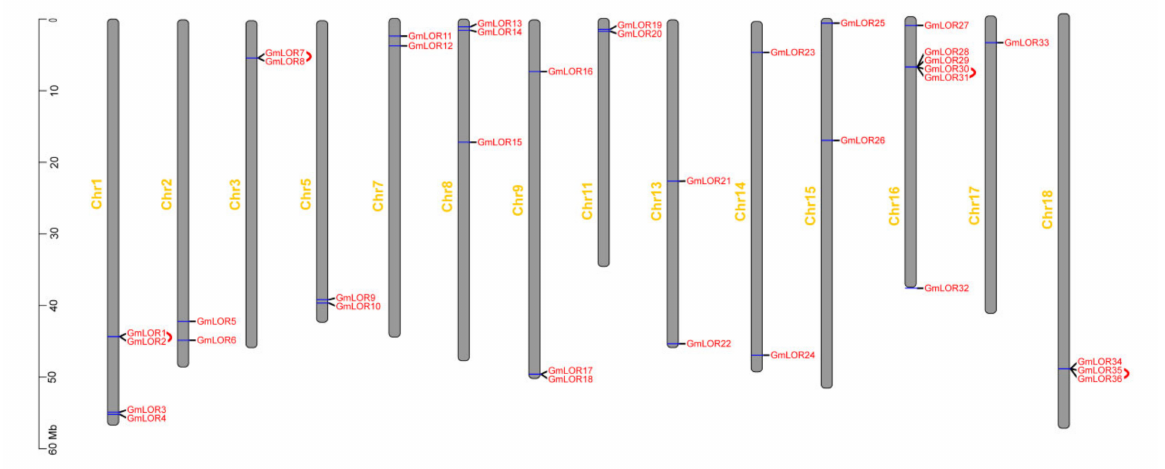
Figure 3. Chromosomal distribution and tandem duplications of GmLORs. The 36 GmLORs were mapped onto soybean chromosomes based on their physical positions. Four tandemly duplicated gene-pairs are labeled by red lines. The scale on the left is in megabases